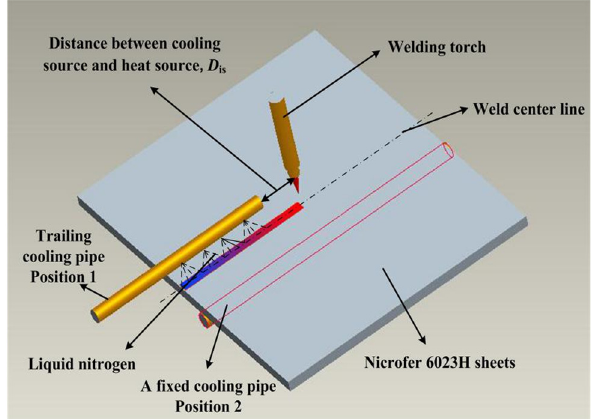
Figure 3: Schematic diagram of GTAW with trailing cooling